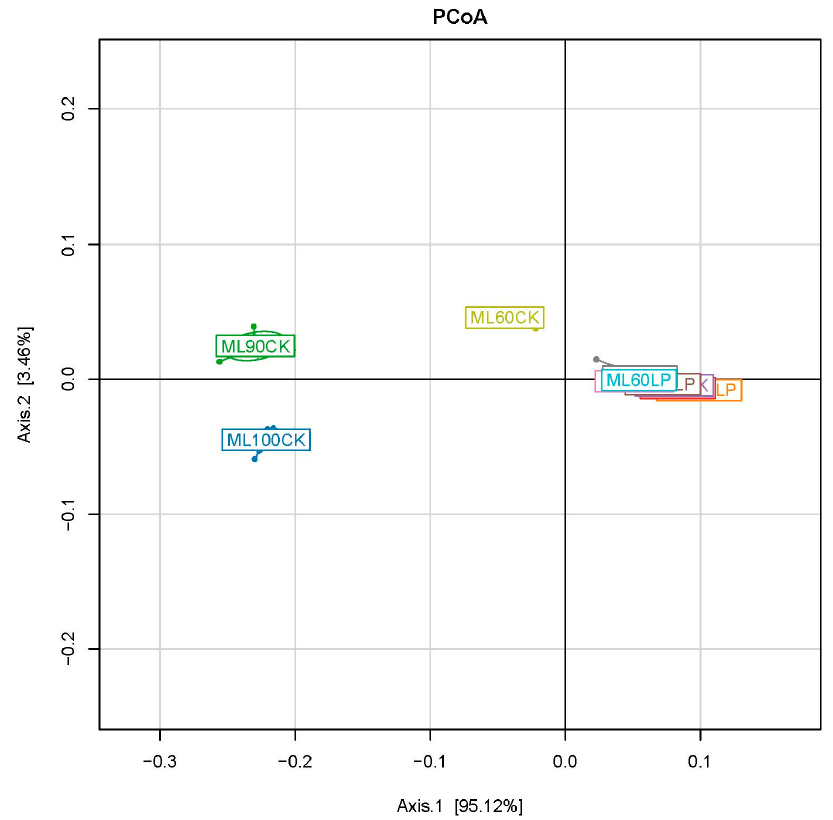
Figure 3. Cluster analysis of bacterial communities in mixed silage as assessed by a Principal Coordinate Analysis. CK, silage without inoculation; LP, silage inoculated with L. plantarum A345. The numbers after “ML” indicate proportion of mulberry leaves in silage.